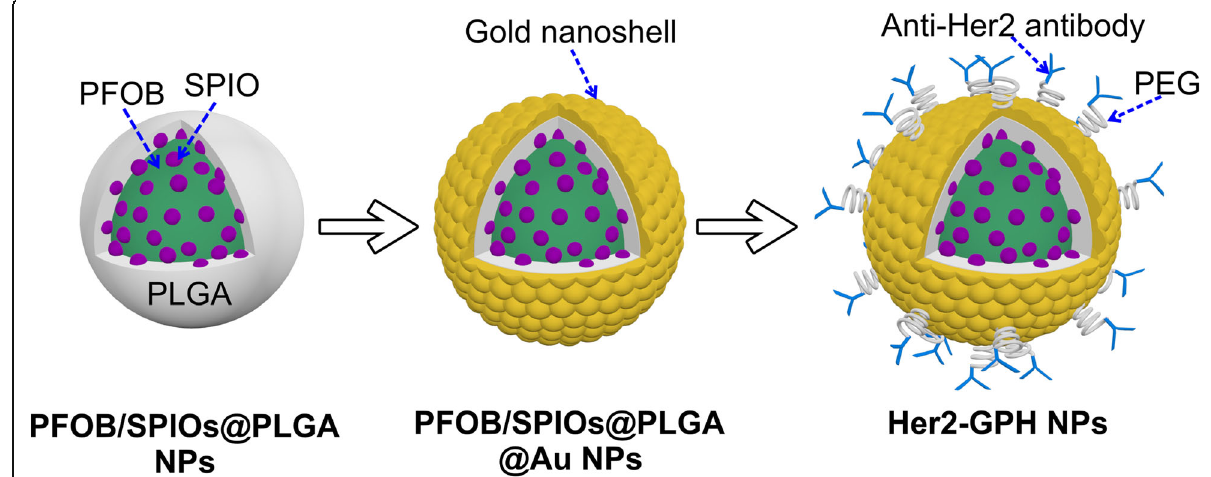
Fig. 1 Schematic illustration of the fabrication procedure of Her2-GPH